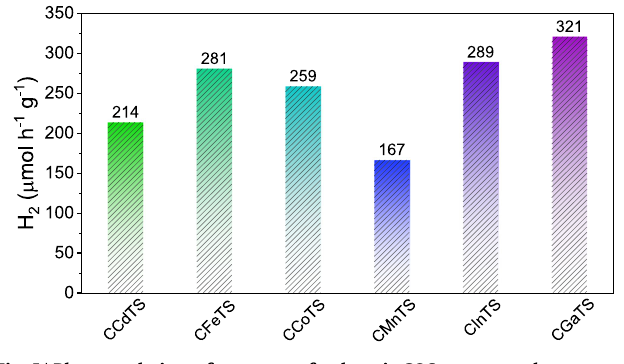
Fig. 5 | Photocatalytic performances of polytypic CQS nanocrystals. Comparison of hydrogen evolution activities of polytypic CQS